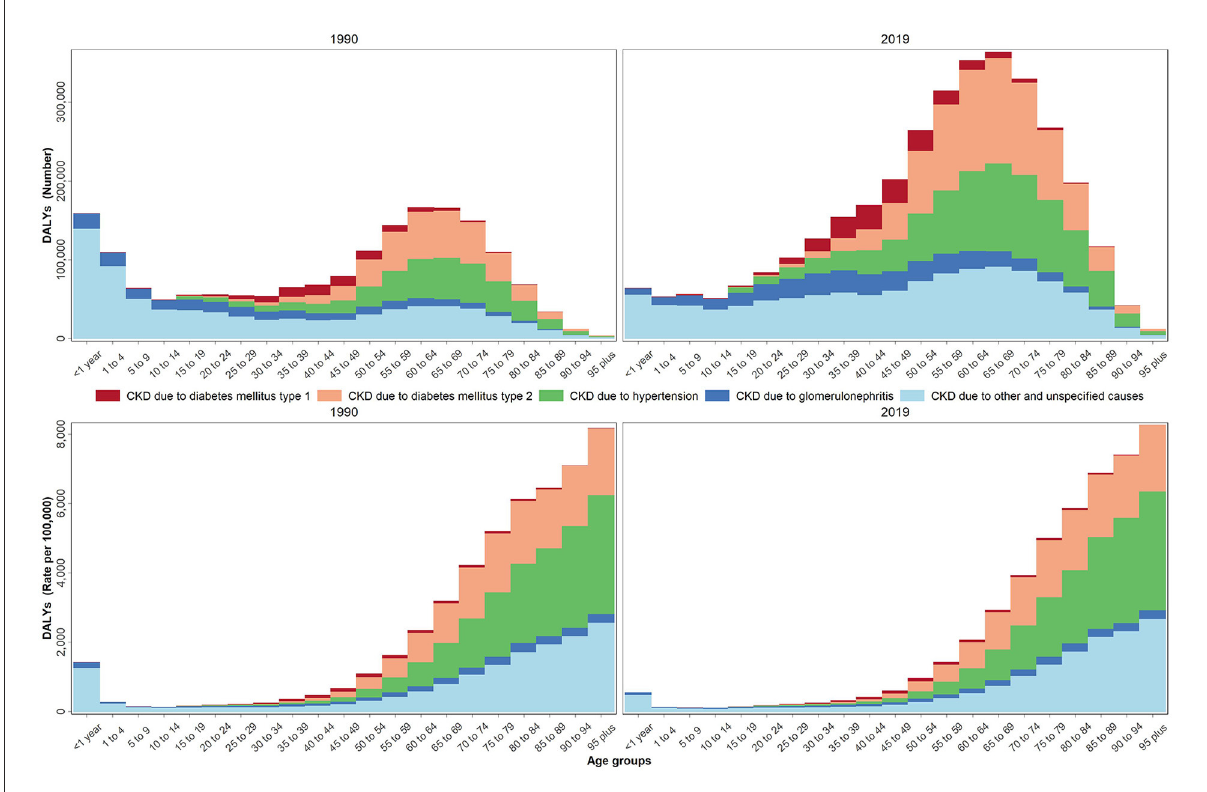
FIGURE2 DALYs number and rate by age groups due to CKD by underlying causes in 1990 and 2019 in the NAME region.